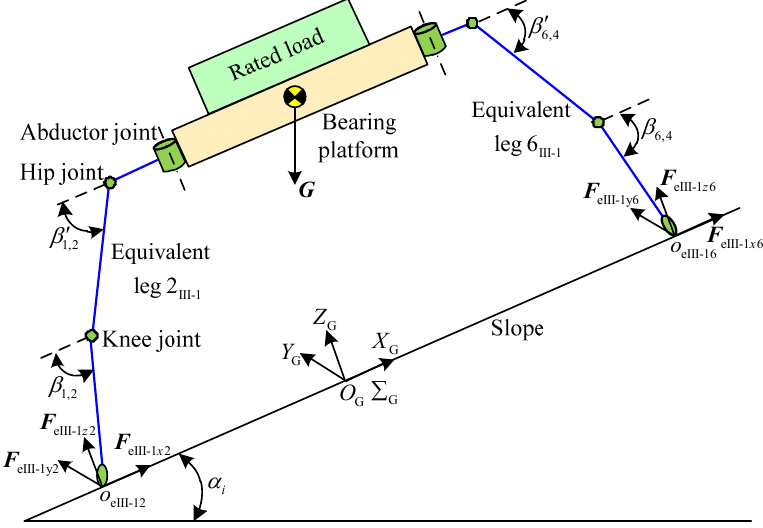
Figure 15. Equivalent model of support phase under working condition III ‐ 1.